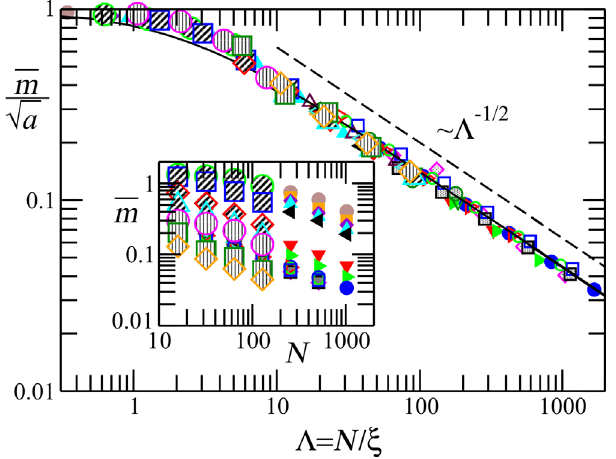
ffiffiffi p a FIG. 8. Scaled time-average magnetization ¯ m= versus the scaling parameter Λ ¼ N= ξ for a one-dimensional photonic network with constant ( J 0 ¼ 1 ) nearest-neighbor couplings 2 ). The various symbols and colors (coordination number n c ¼ indicate different set of nonlinearities χ (full symbols, χ ¼ 1 , a ¼ 1 ; open symbols, χ ¼ 0 . 1 , a ¼ 1 ; partially filled symbols, χ ¼ 0 . 01 , a ¼ 1 ; diagonally striped filled enlarged symbols, χ ¼ 1 , a ¼ 2 ; vertically striped filled symbols, χ ¼ 1 , a ¼ 0 . 1 ) and various h values. The black solid line indicates Eq. (35). The dashed black line has slope Λ − 1 = 2 and it is drawn to guide the eye. In the inset we report the unscaled data for ¯ m